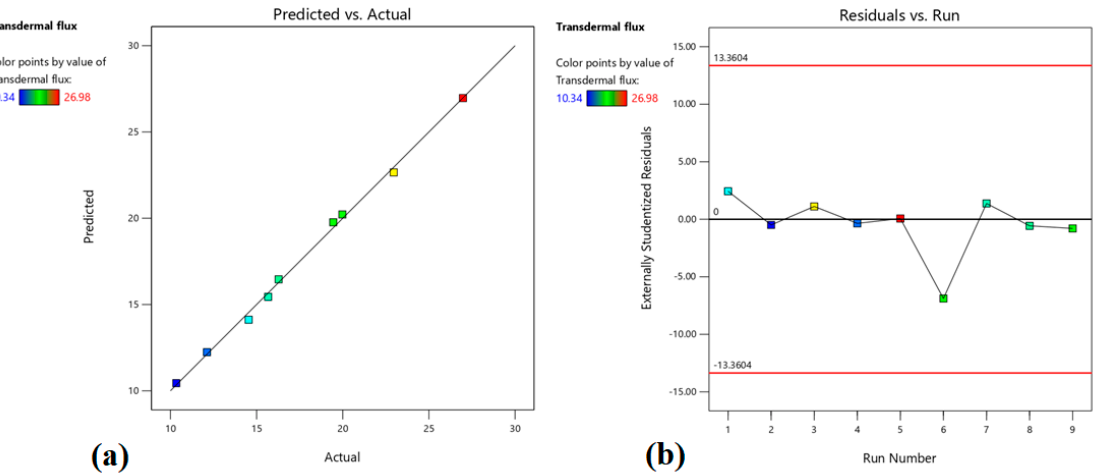
Figure 5. Linear correlation plot of predicted vs. actual ( a ) and related residual plot ( b ) on transdermal flux.